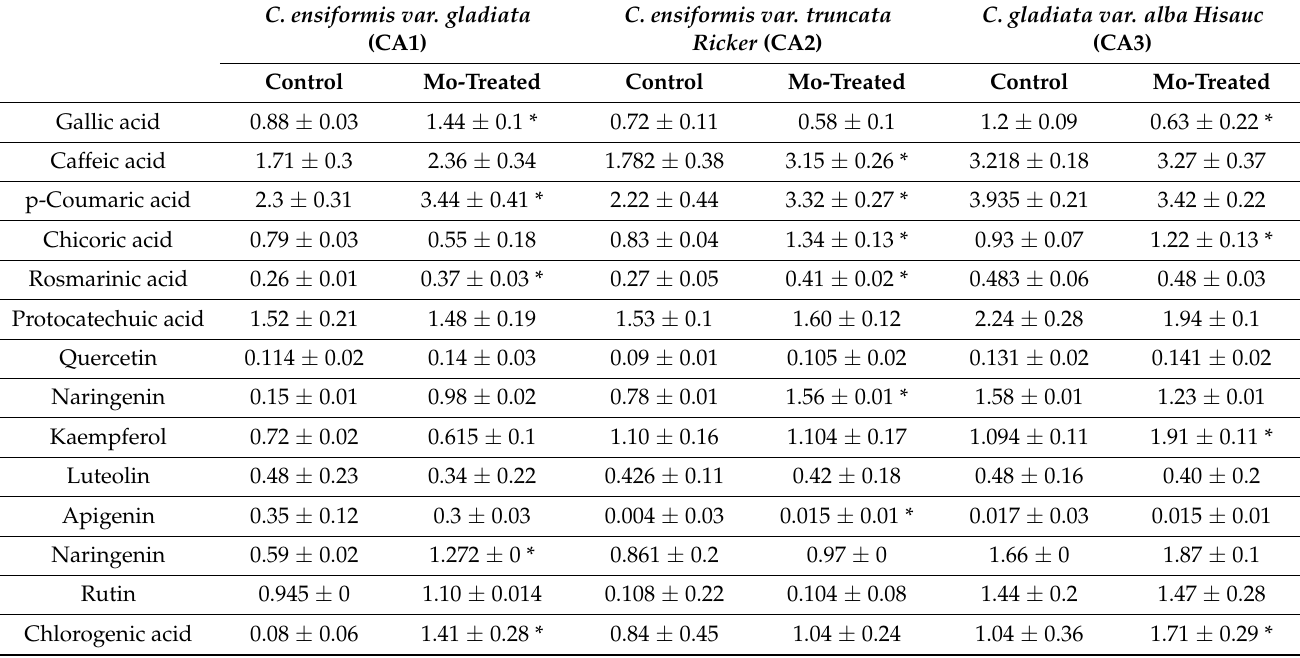
Table 3. Effect of molybdenum treatment on phenolic compounds of Canavalia species/cultivar sprouts. Values are expressed as µ mol/gFW. Experiments were performed in triplicate and the data are shown as mean ± standard deviation (S.D); Asterisks (*) show the level of significance, * p < 0.05; Mo,